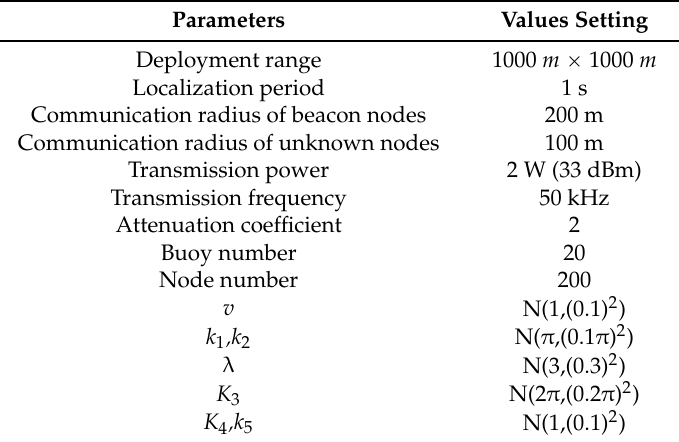
Table 1. Simulation Parameters Setting.